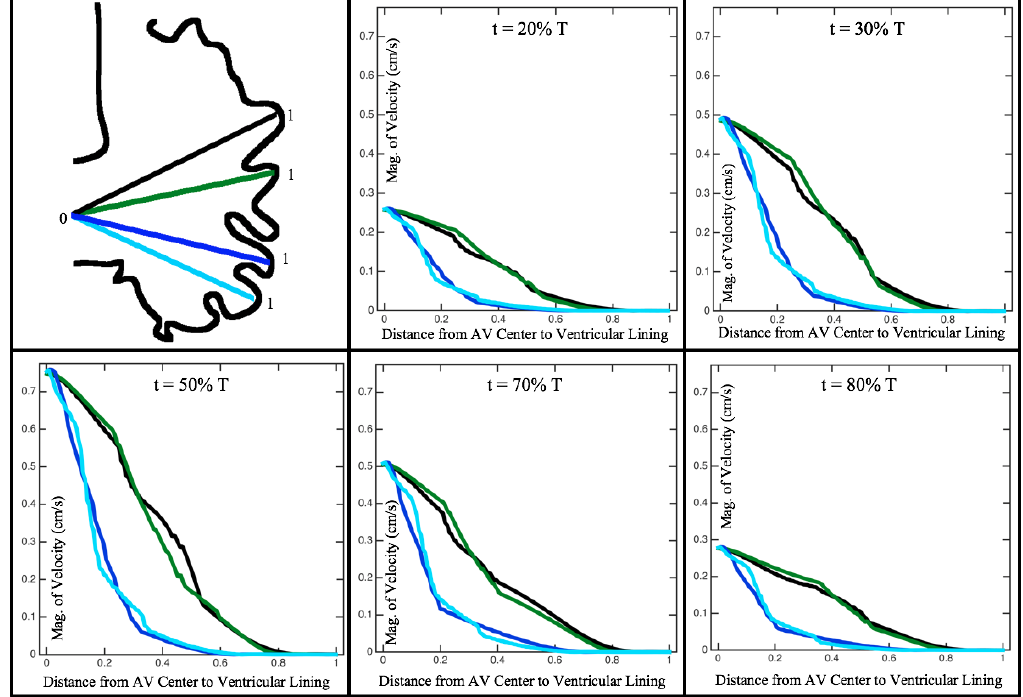
Figure A3. Plots showing how the magnitude of velocity decays from the center of the atrioventricular (AV) canal to the ventricle wall for four different lines across the chamber using a 5 dpf WT (I) embryo’s